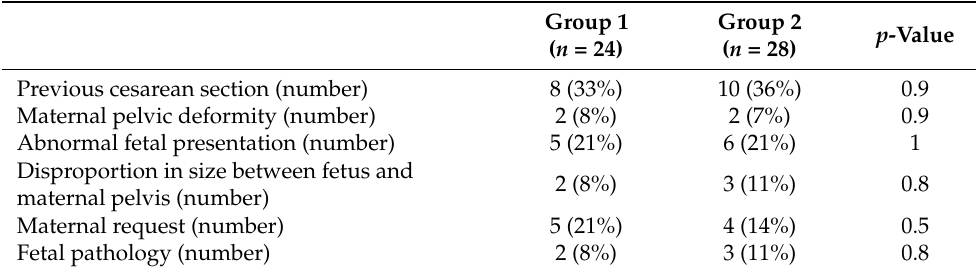
Table 2. Indications for elective cesarean